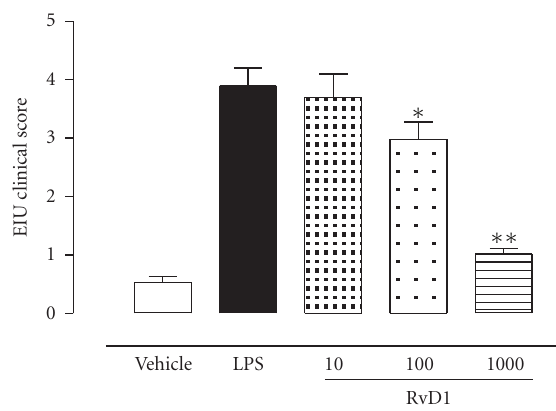
Figure 1: E ff ects of resolvin D1 on clinical development of EIU. The rats were treated with vehicle (PBS) and resolvin D1 (RvD1; 10, 100, 1000 ng/kg) 1 hour before LPS (200 μ g/rat) injection and were evaluated 24h after LPS injection. Clinical manifestations of EIU were graded as reported in test (see Section 2). Values are reported as the mean ± SE, n = 6 per group. ∗ P < 0 . 05 and ∗∗ P < 0 . 01 compared with LPS-treated group.